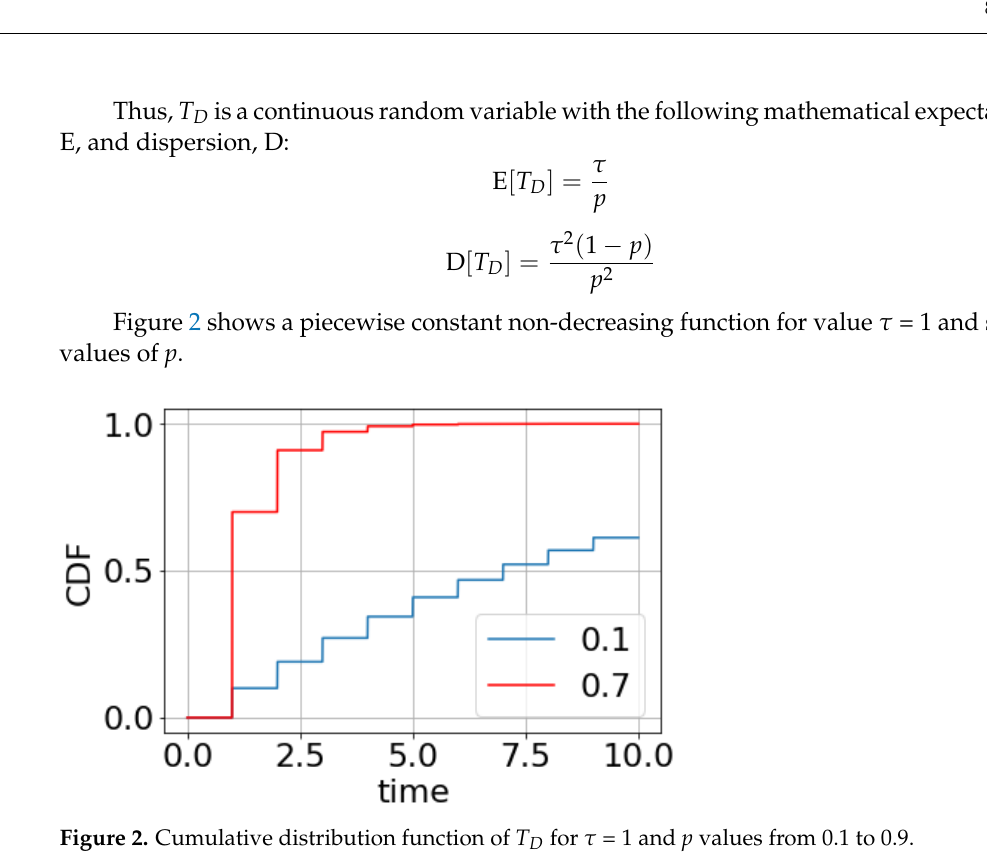
Figure 2. Cumulative distribution function of T D for τ = 1 and p values from 0.1 to 0.9.